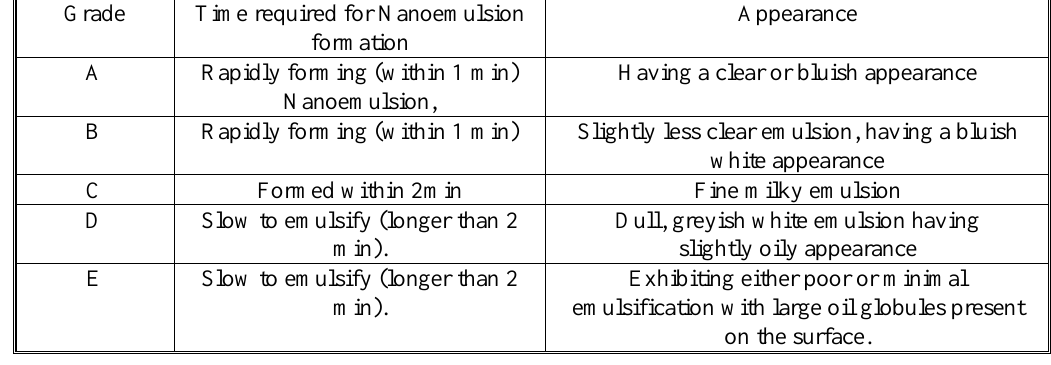
Table 2. Grading system of in vitro performance of the SNEDDS (Dispersibility and self-nano emulsification time)